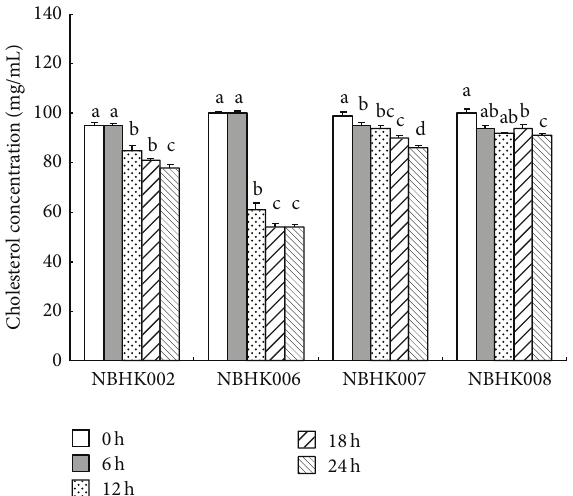
Figure 3: Lowering the micellar solubility of cholesterol by pro- biotics in vitro . a , b , c , d Means with different superscript letters are significant differences ( 𝑃 < 0.05 ) by Duncan’s multiple range